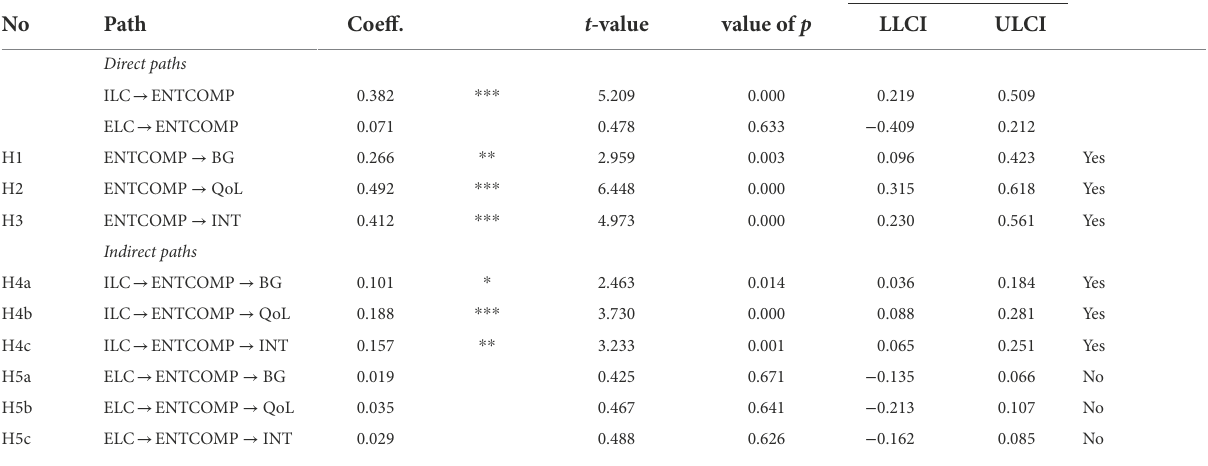
TABLE 4 Hypothesis